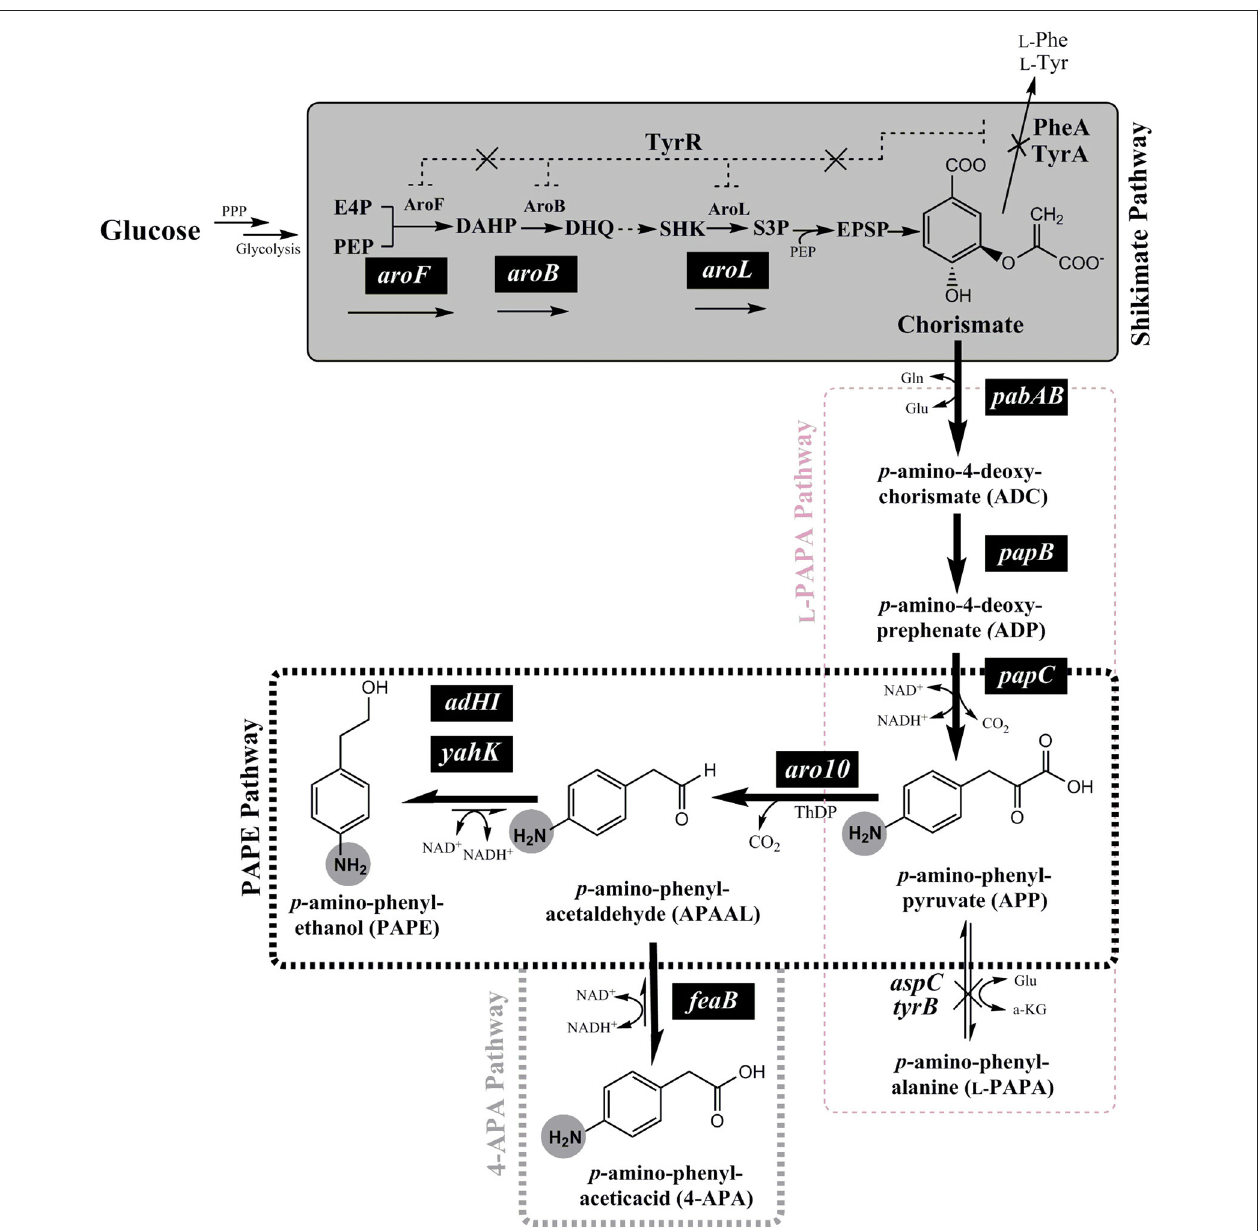
FIGURE 1 | Schematic overview of the de-novo biosynthesis pathway of para- amino phenylethanol (PAPE) or para- amino phenylacetic acid (4-APA) via expanded shikimate pathway in E. coli strains from glucose. The genes expressed from plasmids are indicated by white letters on black backgrounds ( pabAB, papB, papC, aro10, aroF, aroB, aroL, adHI, adHII, yahK , or feaB ). Enzymes and molecules are abbreviated as follows: G6P, glucose 6-phosphate; F6P, fructose 6-phosphate; F1.6-BP, fructose 1,6-bisphosphate; G3P, glyceraldehyde 3-phosphate; DHAP, dihydroxyacetone phosphate; PPP, Pentose phosphate pathway; E4P, erythrose 4-phosphate; PEP, phosphoenolpyruvic acid; DAHP, 3-deoxy-D-arabinoheptulosonate 7-phosphate; DHQ, dehydroquinate; SHK, shikimic acid; S3P, shikimate 3-phosphate; aroF , DAHP synthase; aroB , dehydroquinate synthase; aroL , shikimate kinase I; pabAB , p -amino-4-deoxychorismate (ADC) synthase; papB , ADC mutase; papC , p -amino-4-deoxyprephenate dehydrogenase; tyrB , aromatic aminotransferase; aspC , aspartate aminotransferase; aro10 , ThDP-ketoacid decarboxylase; ADHI and ADHII , alcohol dehydrogenase I and II; yahK , aldehyde reductase; feaB , phenylacetaldehyde